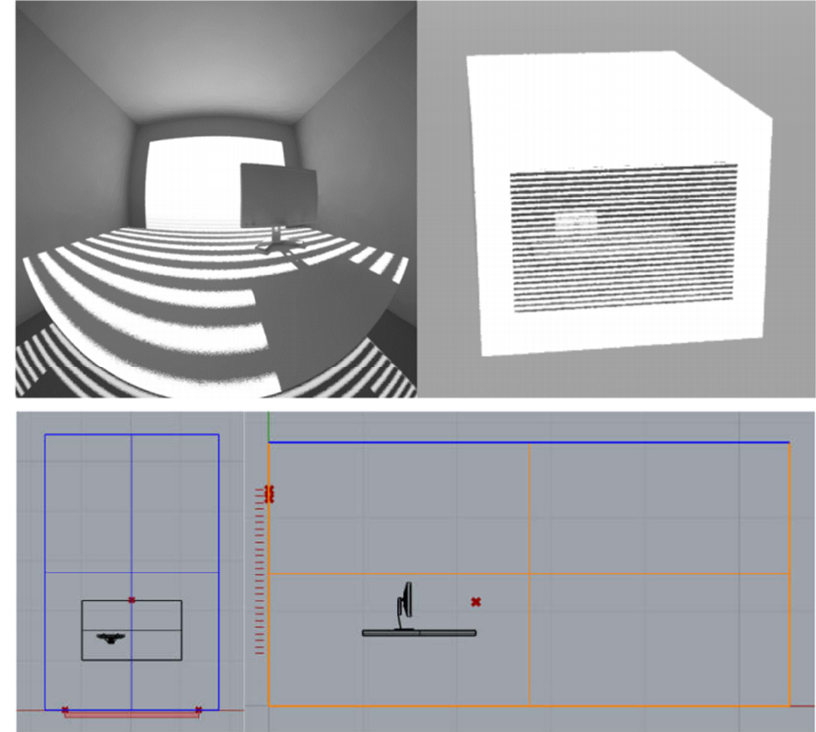
Figure 6. Layout of case 1 room. Table 4. Summary of room parameters in case